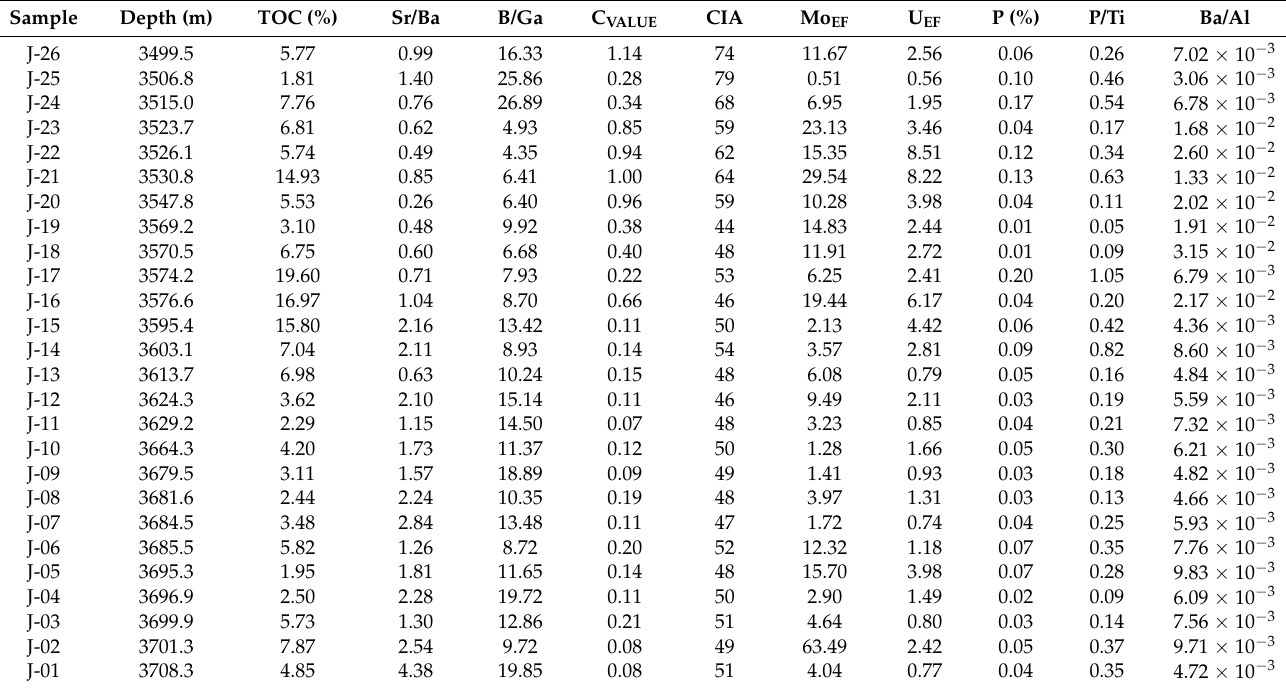
Table 1. TOC and element ratios of the Lucaogou Formation.